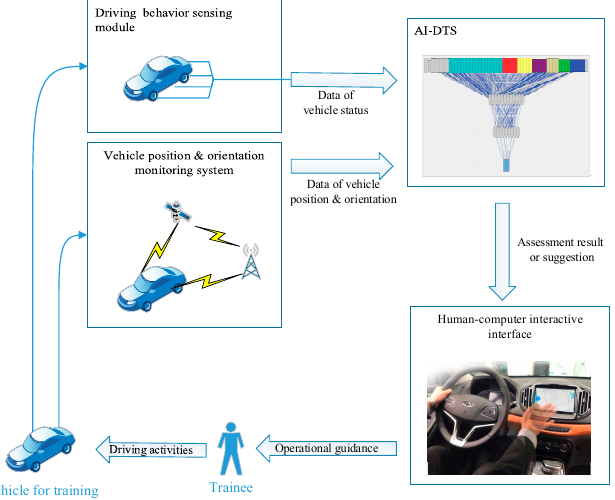
Figure 4. The framework and process model of AI-DTS.